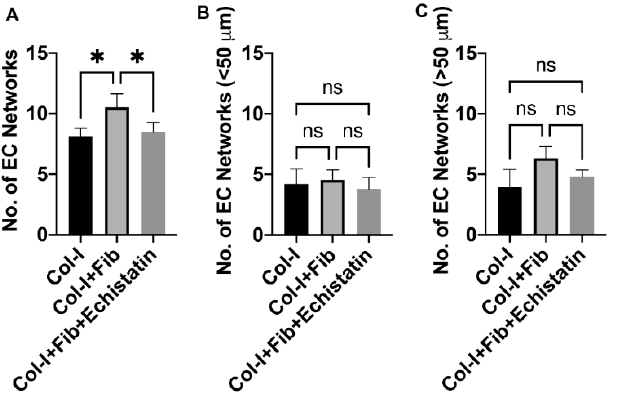
Figure 2. Quantification of EC networks in HUVEC only hydrogel. The graphs show quantification of ( A ) total number of EC networks, ( B ) networks less than 50 µm, and ( C ) networks more than 50 µm. The different hydrogels were collagen only (Col-I), fibronectin functionalized collagen hydrogel (Col-I + Fib), and Col-I + Fib hydrogel treated with Echistatin (Col-I + Fib + Echistatin). Statistical significance was determined using One-way ANOVA (* p < 0.05; n = 3).